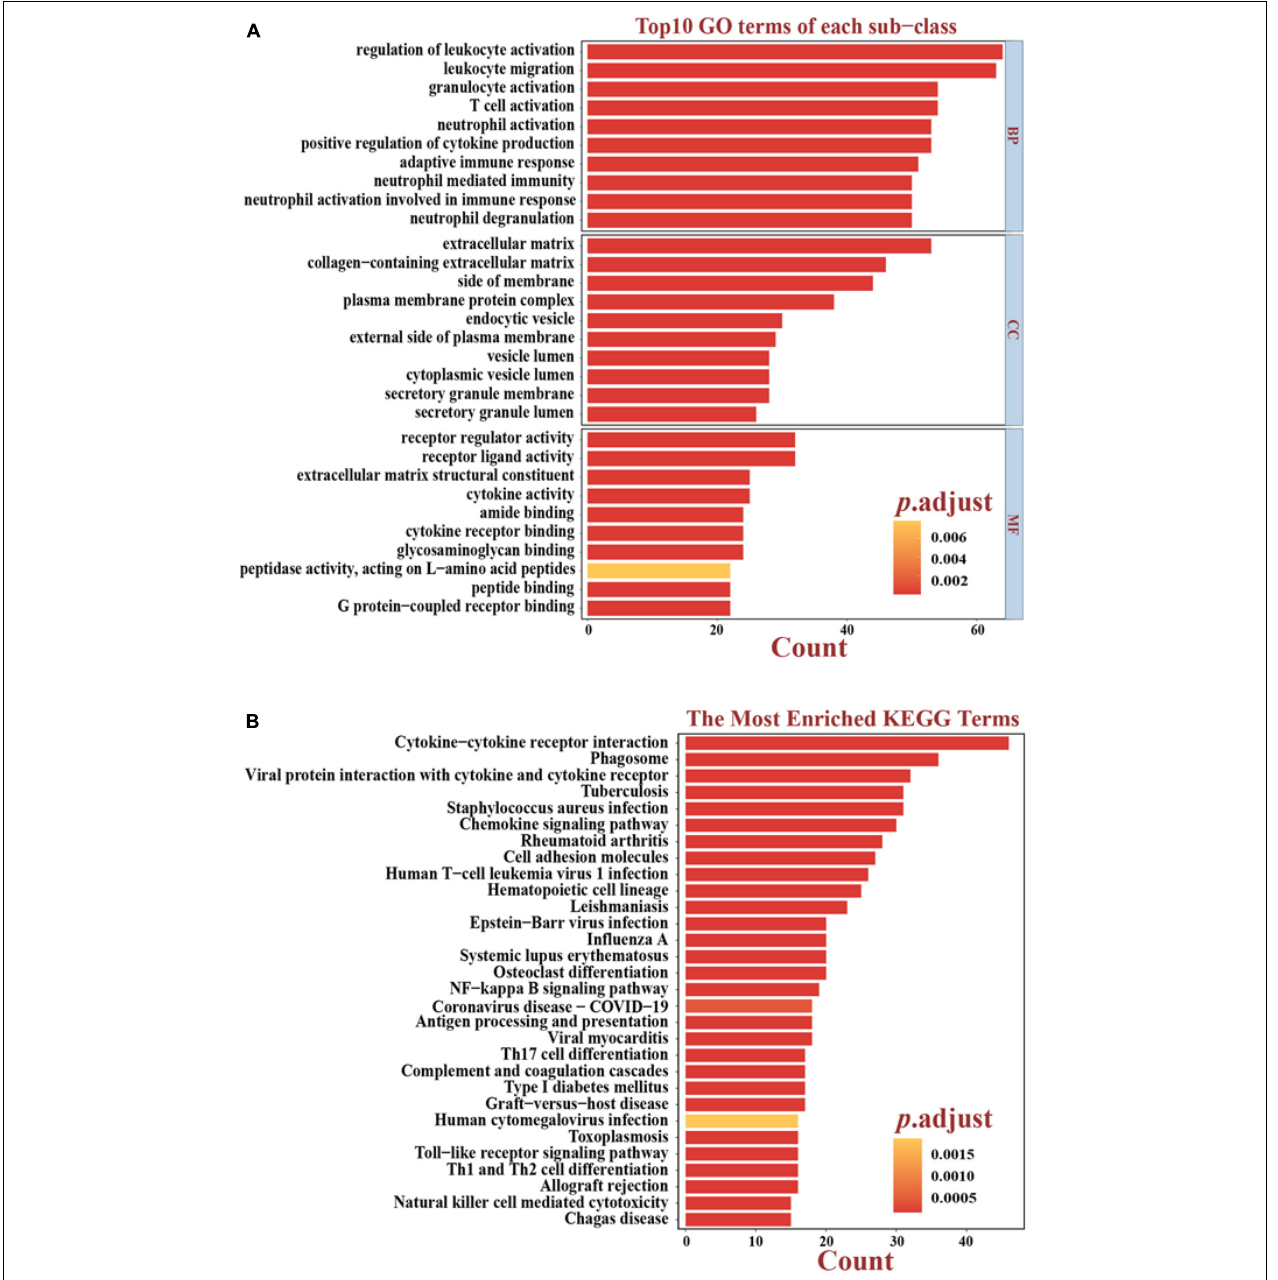
FIGURE 2 | Functional analyses based on differentially expressed genes (DEGs). (A) Top 10 results of the GO enrichment analysis in BP, CC, and MF. The bright yellow-to-salmon pink chromatograms indicate the corresponding p values corrected by the BH method. (B) Top 30 results of the KEGG enrichment analyses. The bright yellow-to-salmon pink chromatograms indicate the corresponding p values corrected by the BH method. GO, Gene Ontology; KEGG, Kyoto Encyclopedia of Genes and Genomes; BP, biological processes; CC, cell components; MF, molecular functions.